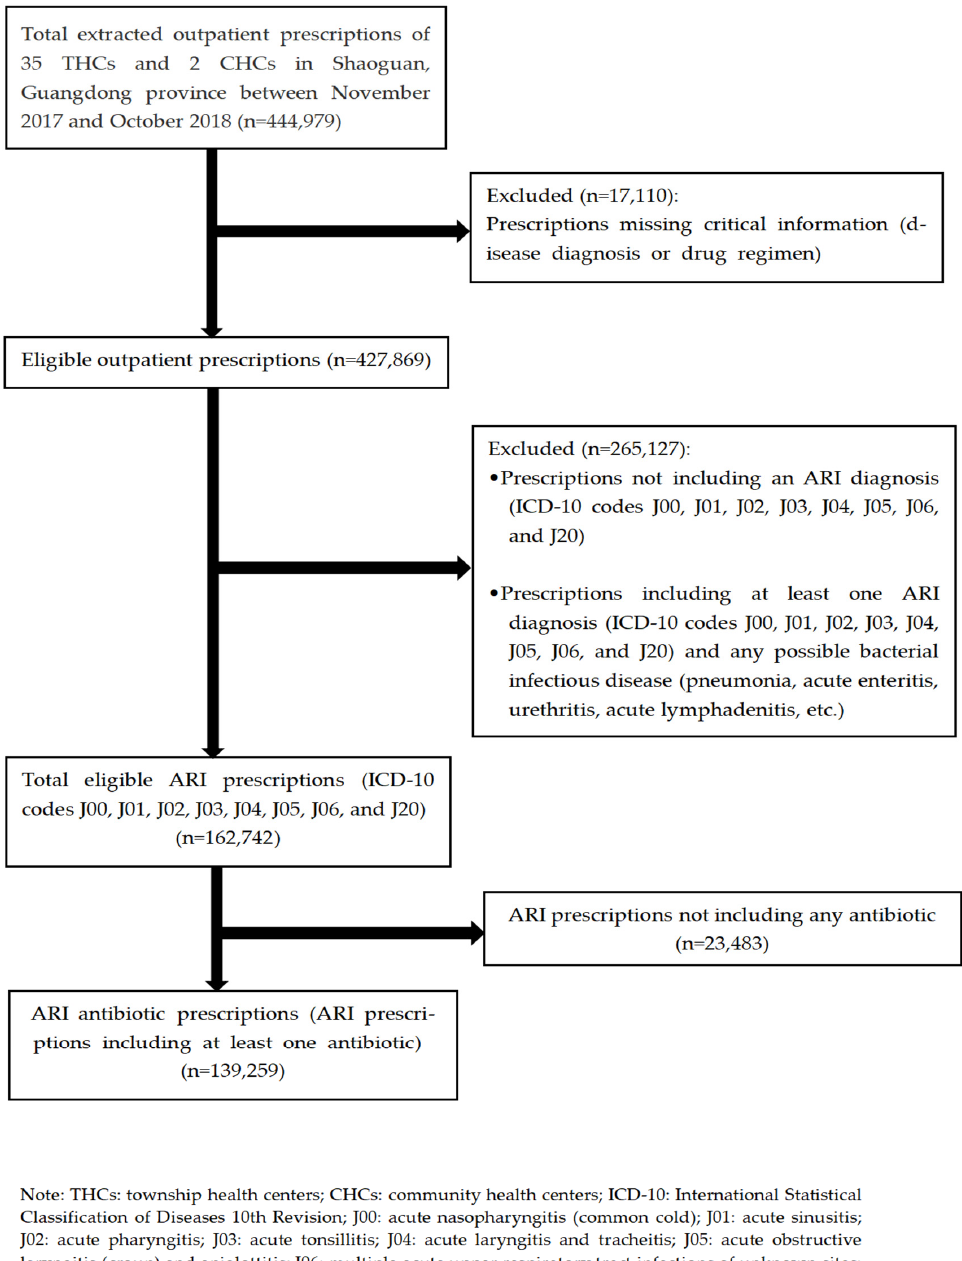
Figure 1. Flow chart of the selected acute respiratory infection (ARI) prescriptions for our study in rural Guangdong, China (November 2017 to October 2018).